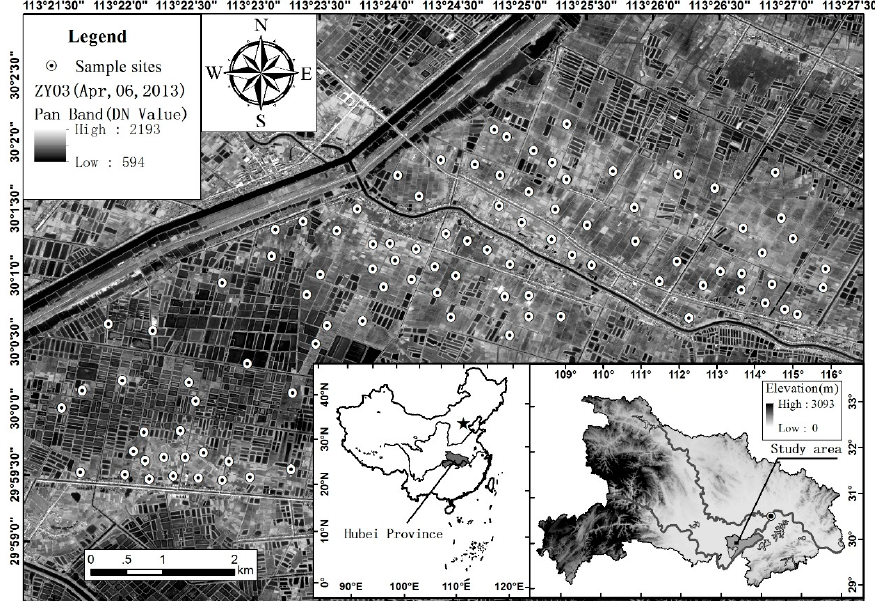
Figure 1. Maps showing the distribution of sampling sites (located at Honghu City in Hubei Province, China) and landscape of the study area, indicated by a 2.1 m resolution panchromatic image from the Chinese Earth resources satellite Zi Yuan 03 (ZY03) sensor (Kosmos Company of Remote Sensing, Beijing, China).